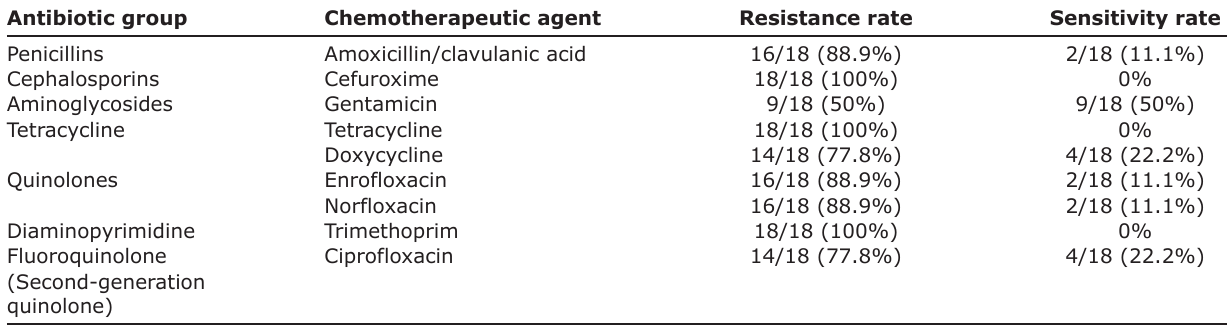
Table-4: Phenotypic susceptibility patterns of Escherichia coli isolates. Antibiotic